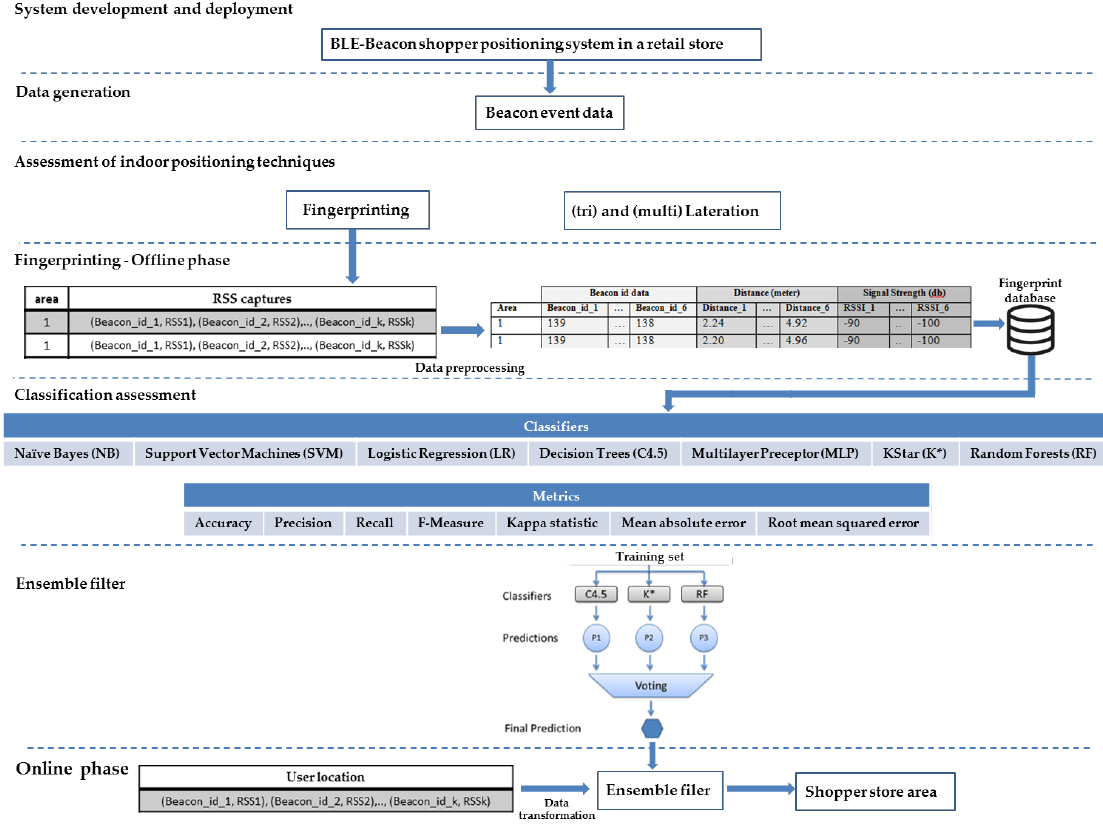
Figure 1. Methodology phases.